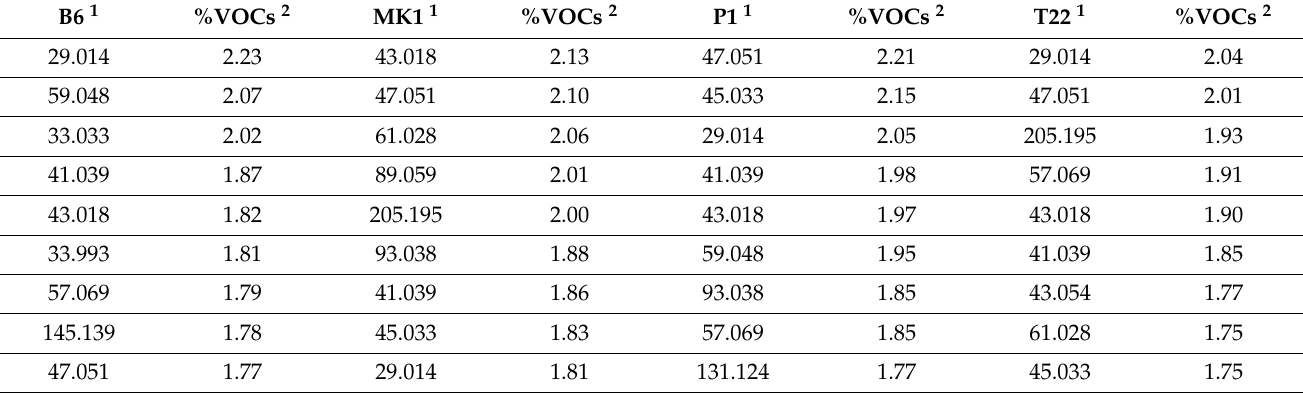
Table 1. Emissions of the Top 20 VOCs of Trichoderma isolates grown on